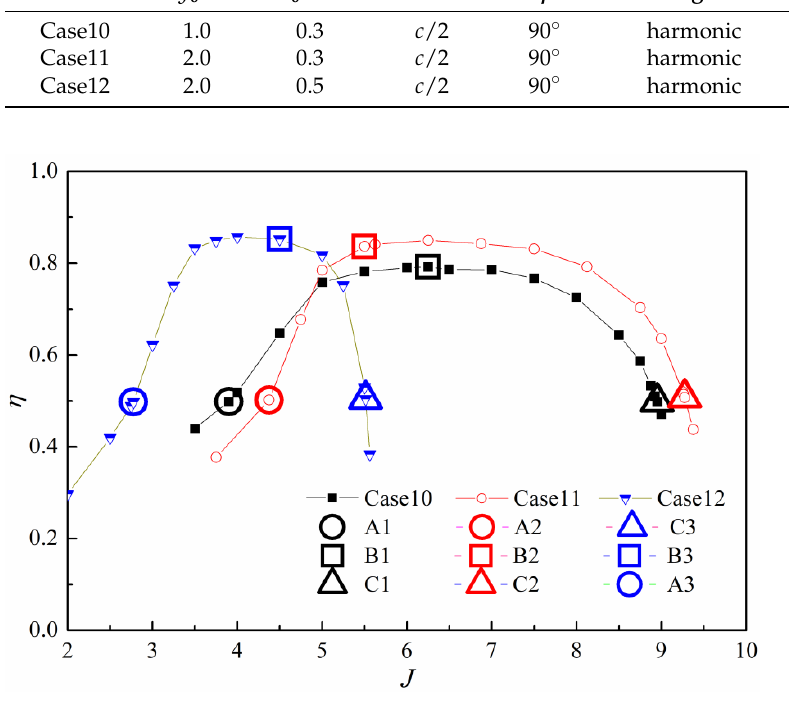
Figure 21. Efficiency curve and nine analysis points selected in three cases.